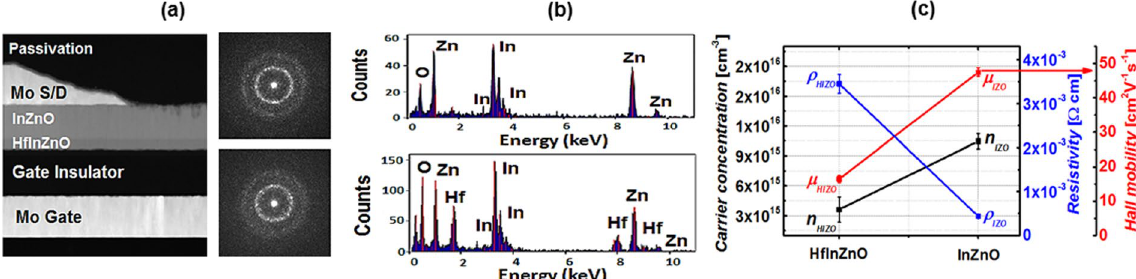
Figure 1. ( a ) Cross-sectional high annular transmission electron microscopy image of bilayer oxide TFT and transmission electron diffraction patterns of IZO (right top) and HIZO (right bottom) ( b ) Energy dispersive spectroscopy data of IZO (top) and HIZO (bottom). ( c ) Comparison of electrical properties for single-layer HIZO and IZO thin film by Hall effect